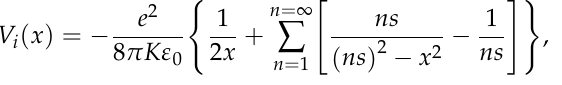
Figure 3. Variants of the inner atomic structure of hydrogenized gold nanoparticles on HOPG: ( a ) dissolution of hydro- gen atoms in gold; ( b ) formation of surface and subsurface layers of hydrogen atoms. In the case of hydrogen dissolution, HOPG-supported gold nanoparticles with pe- ripheral semiconducting areas can be described as junctions with a met- al-semiconductor-metal (MSM)-type structure. Indeed, carbon and gold with metal elec- tronic structures are separated from each other in some volume by hydrogenized gold with a semiconductor structure. Due to charging effects at the interfaces between pure and hydrogenized gold and between hydrogenized gold and carbon, the form of the potential barrier will change, and the observed band gap of hydrogenized gold will also change. Let us consider this process.